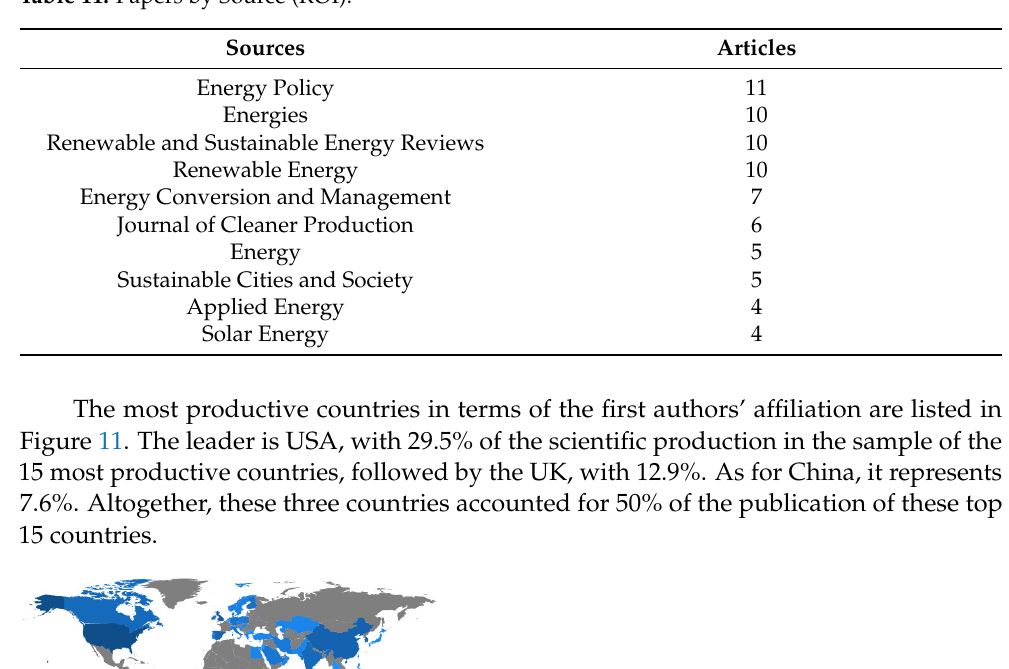
Table 11. Papers by Source (ROI).